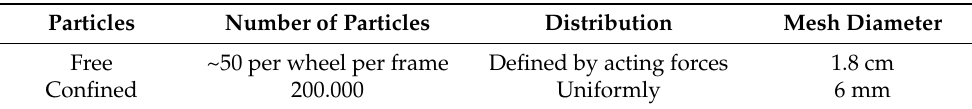
Table 2. Number of particles